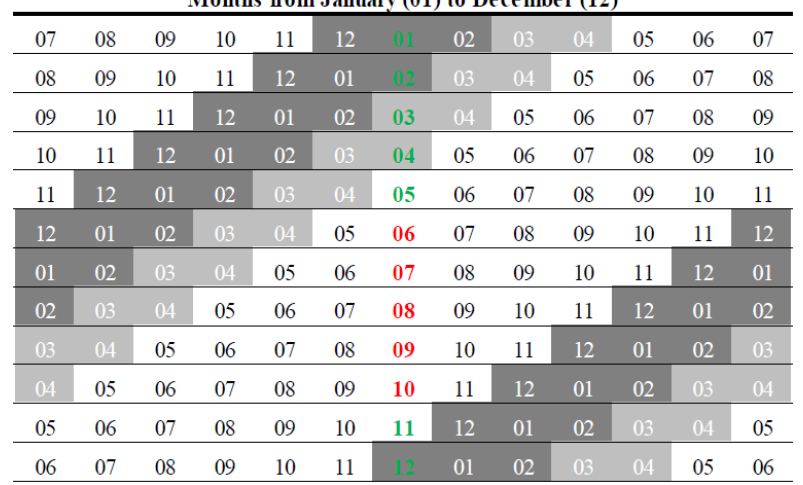
Table 1. The calculation years used for the boxplots of Fig. 8. For example, the first row shows a calculation year starting in July and ending in July, where the Fyw result was assigned to January. Grey shaded areas are the usual beginning of snowfall and the final snowmelt (December to February; dark shading), with an assumed prolonged influence of snowmelt on streamflow until April (light shading). Green calculation years highlight snow influence of only one winter within this year, while red calculation years highlight influence of two different